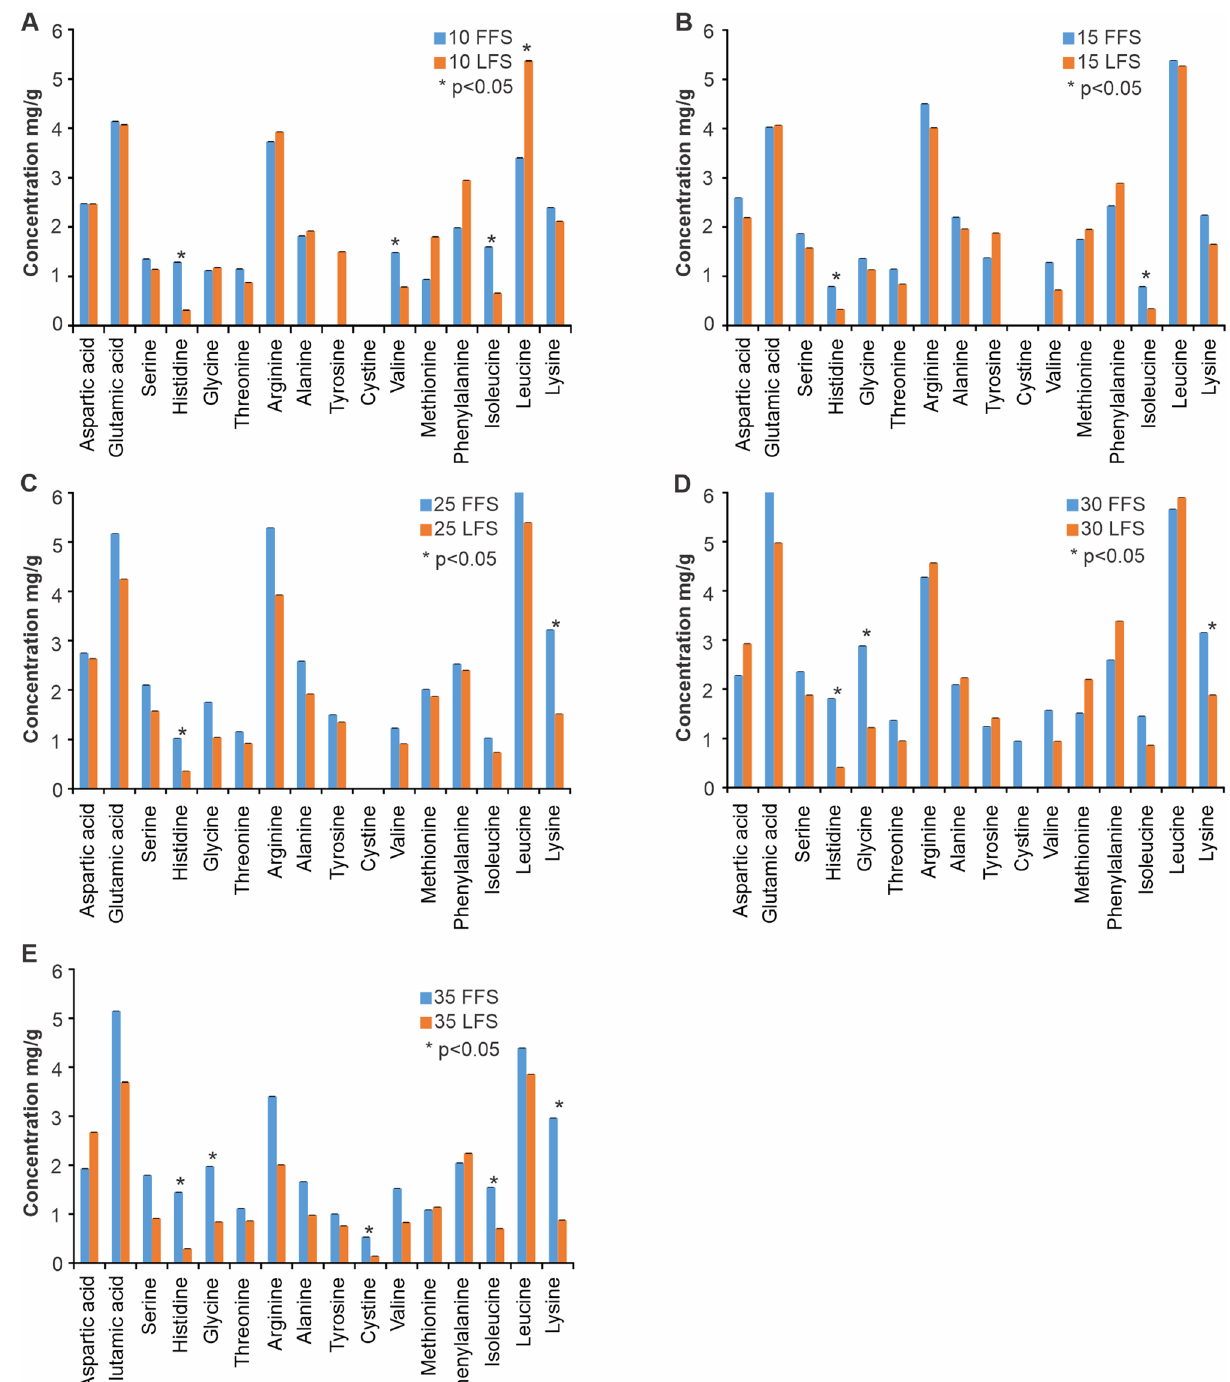
Figure 1. Composition of total amino acids (mg/g) in two types of fish ensilages (FFS—fat fish silage; LFS— lean fish silage) during 35 days of fermentation (DoF). Data are mean ± SD. * p <